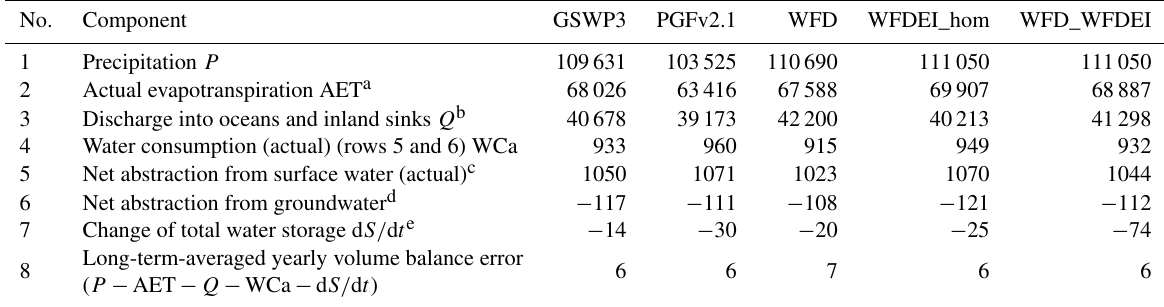
Table 2. Global sums of water balance components for land area (except Antarctica and Greenland) (km 3 yr − 1 ) from WaterGAP (same sorting as Table 2 in Müller Schmied et al., 2014) for the five model variants and the years 1971–2000. Cells representing inland sinks were excluded but discharge into inland sinks was included.